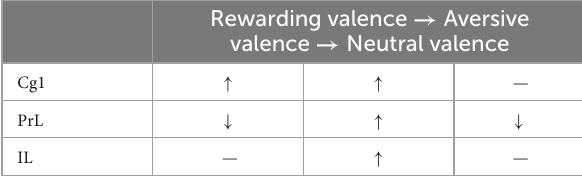
TABLE 3 Changes in saccharin solution consumption by valence, from rewarding/aversive to neutral, under optogenetic ChR2 excitatory stimulation in the Cg1, PrL, and IL.